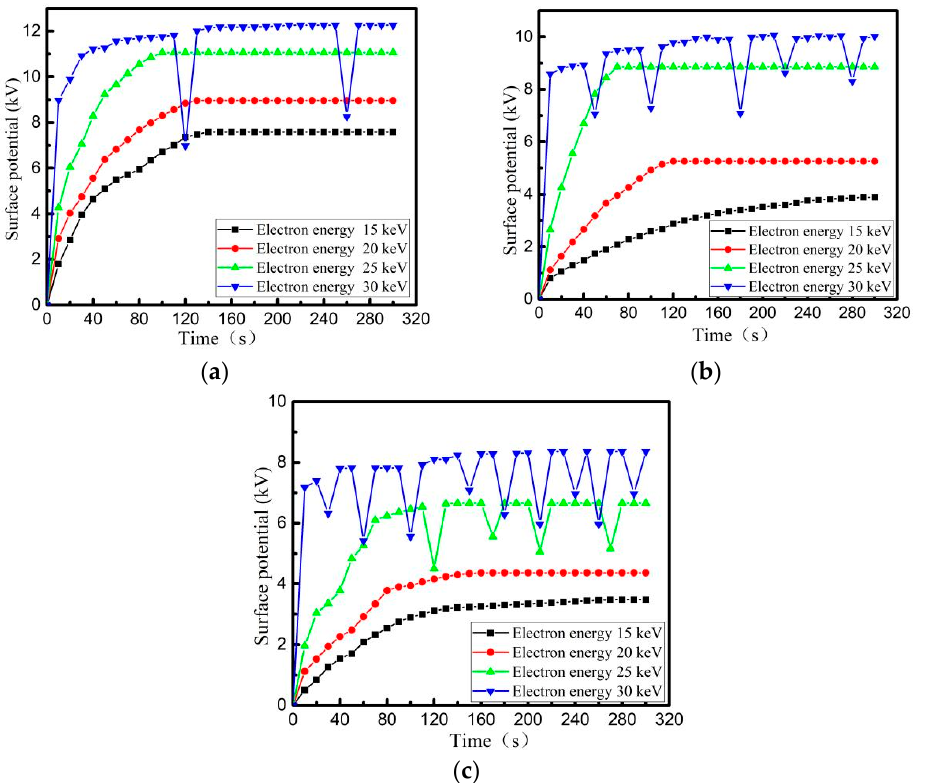
Figure 7. The change law of charging potential on dielectric surface without external field radiation ( a ) PTFE, ( b ) PI, ( c ) EP.